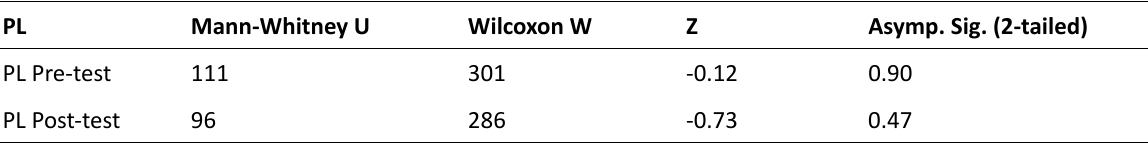
Table 2. Dynamic Balance Ability According to Gender